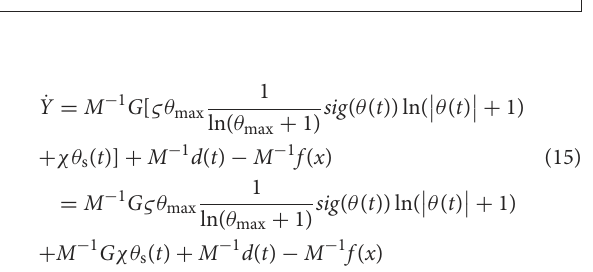
FIGURE4 System input projection